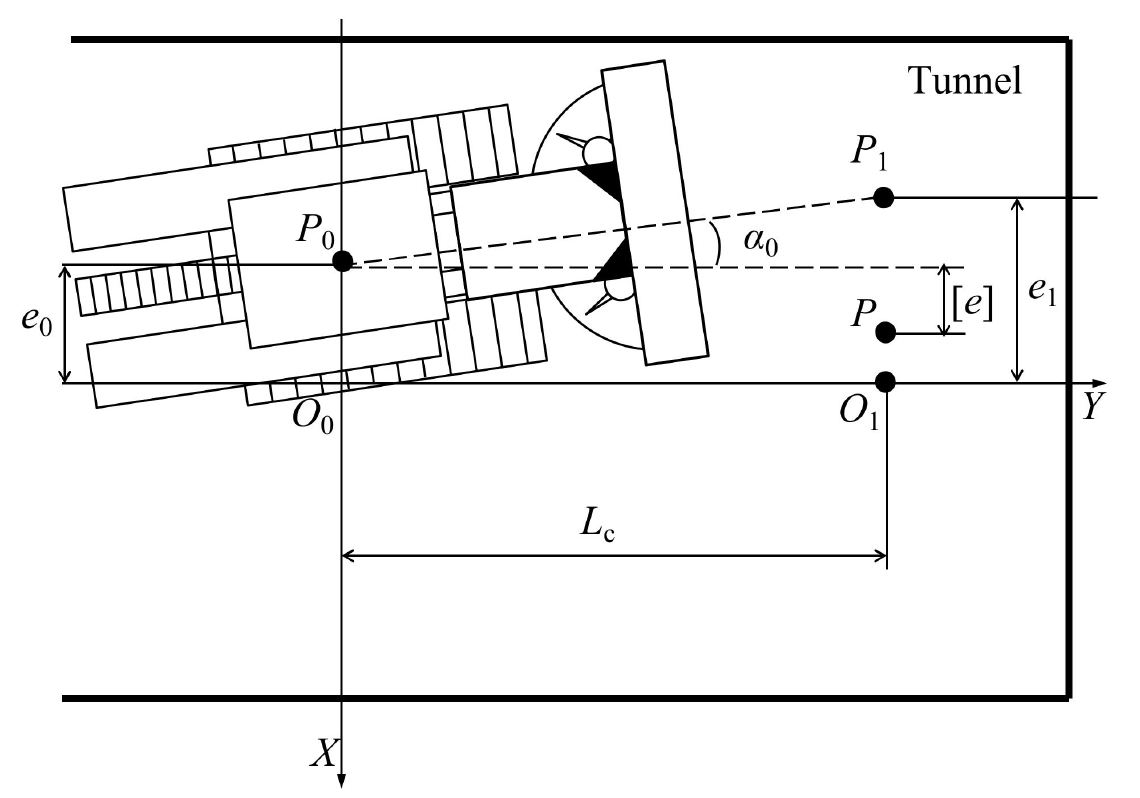
Figure 5. The starting point and endpoint when | e 1 | > | e 0 | and | e 0 | > [ e